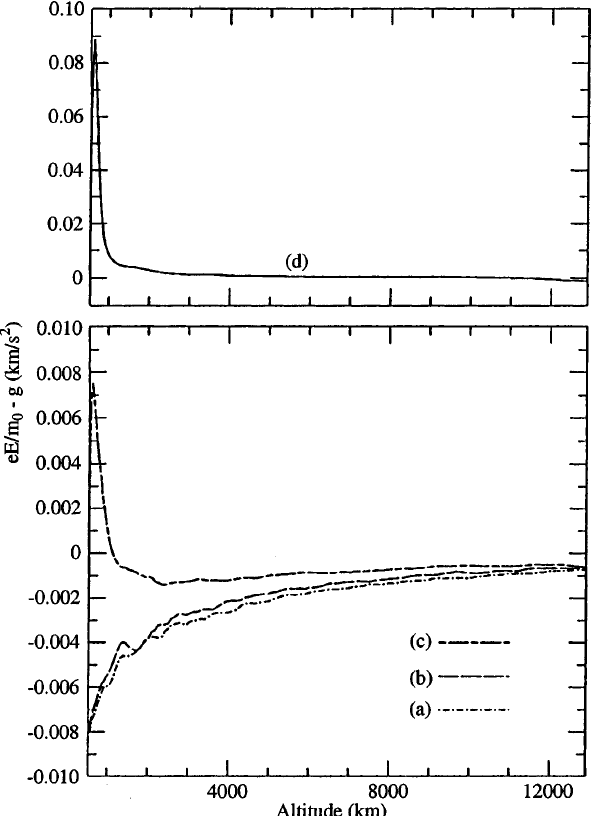
Fig. 17. Profiles of the O (cid:135) acceleration due to the combination of the electric and gravitational fields. The labels correspond to the cases listed in Table 3